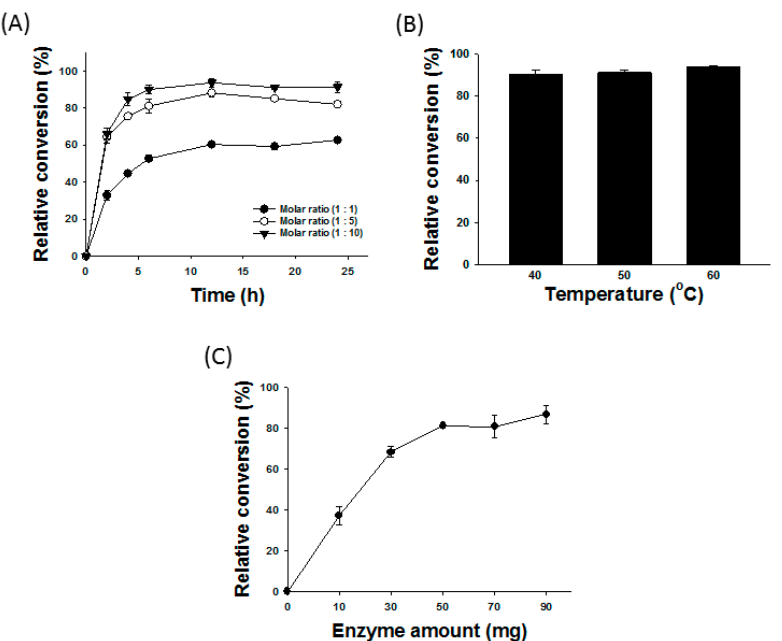
Figure 3. Individual effects of selected experimental parameters on relative conversion of retinyl laurate. ( A – C ) Effects of reaction time and the molar ratio ( A ); temperature ( B ); and enzyme amount (Novozyme ® 435) ( C ) on relative conversion of retinyl laurate. Molar ratio means the ratio of retinyl acetate (mmole) to lauric acid (mmole).